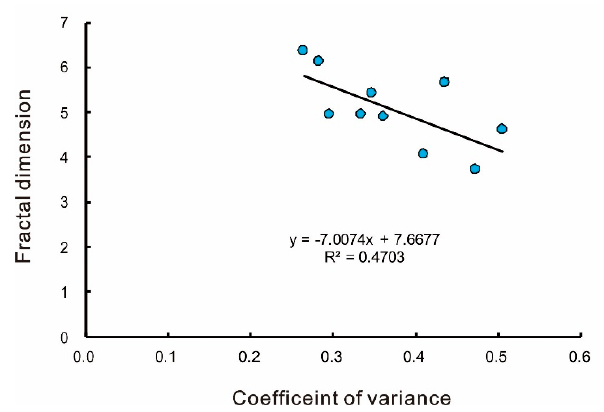
Figure 5. Relationship between the fractal dimension and the coefficient of variation.